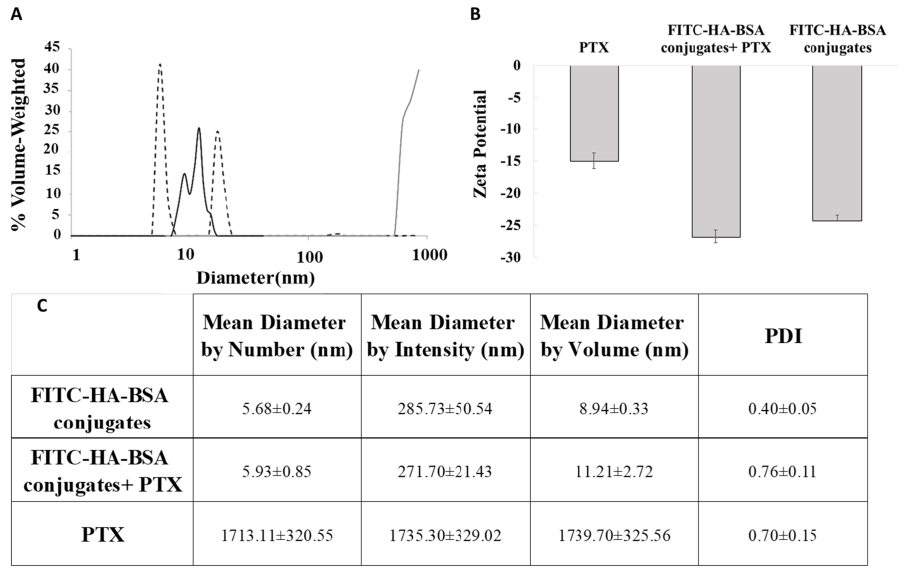
Figure 3. ( A ) Particle size distributions of FITC-HA-BSA conjugates and their self-assemblies (40 µ M; black solid line); of (80 µ M) PTX-loaded conjugate NPs (dashed line), (PTX: FITC-HA-BSA conjugate molar ratio of 2:1), and of pure PTX (80 µ M; gray solid line). ( B ) Zeta potential of FITC-HA-BSA conjugates (40 µ M) and of (80 µ M) PTX-loaded conjugate NPs. ( C ) PDI and mean diameter by number, intensity and volume of the three